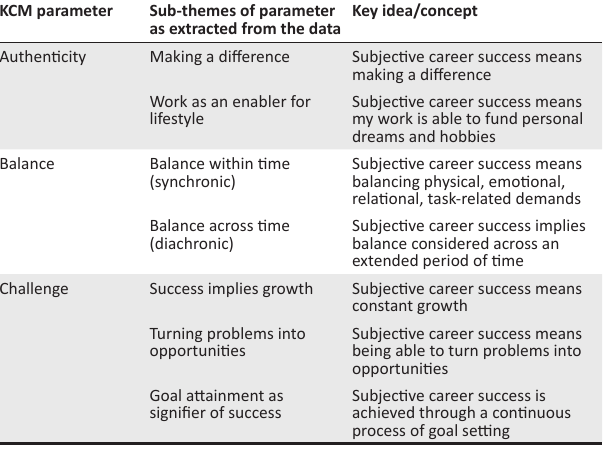
TABLE 1: Sub-themes extracted from the data in relation to the authenticity, balance, challenge (ABC) parameters. KCM